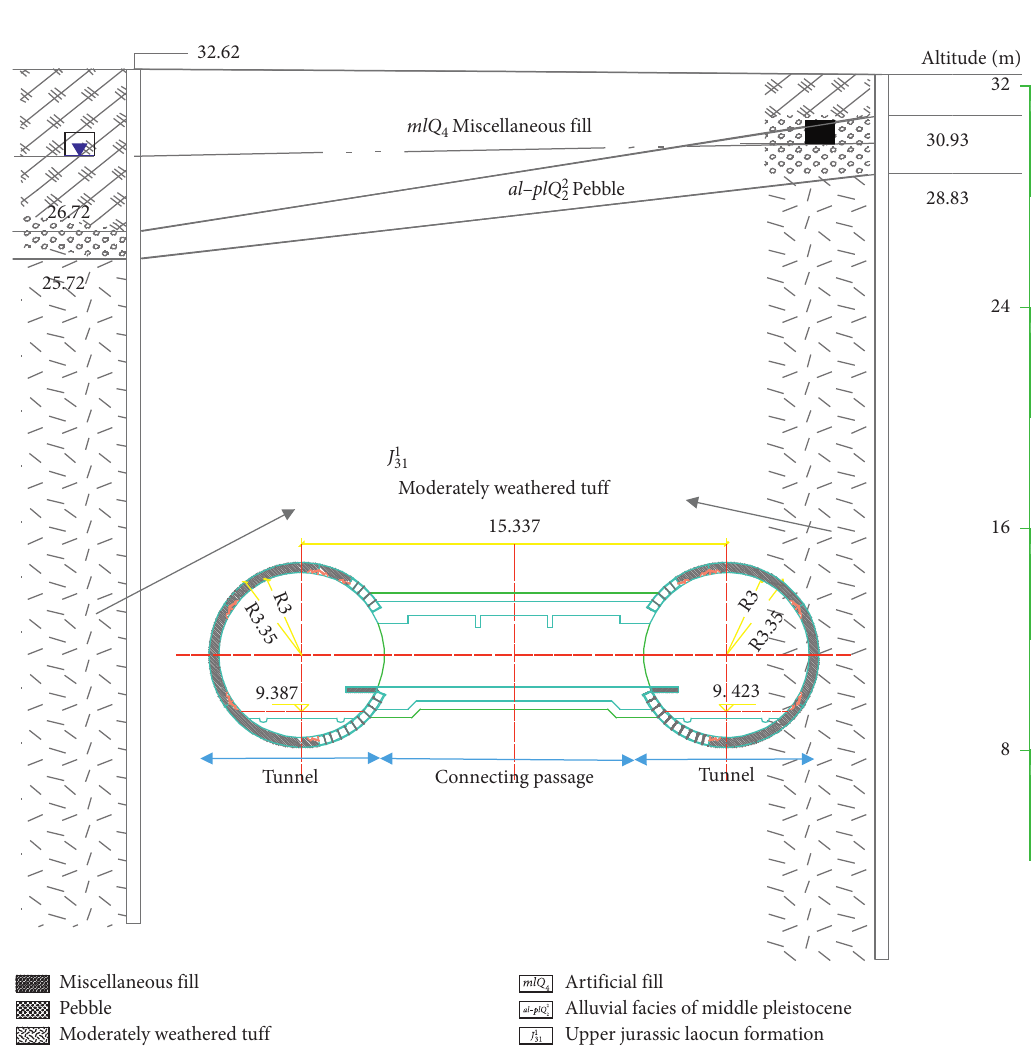
Figure 1: Topographic map.